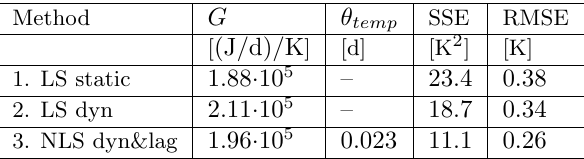
Table 10: Results of estimation of G with different es- timation methods Method